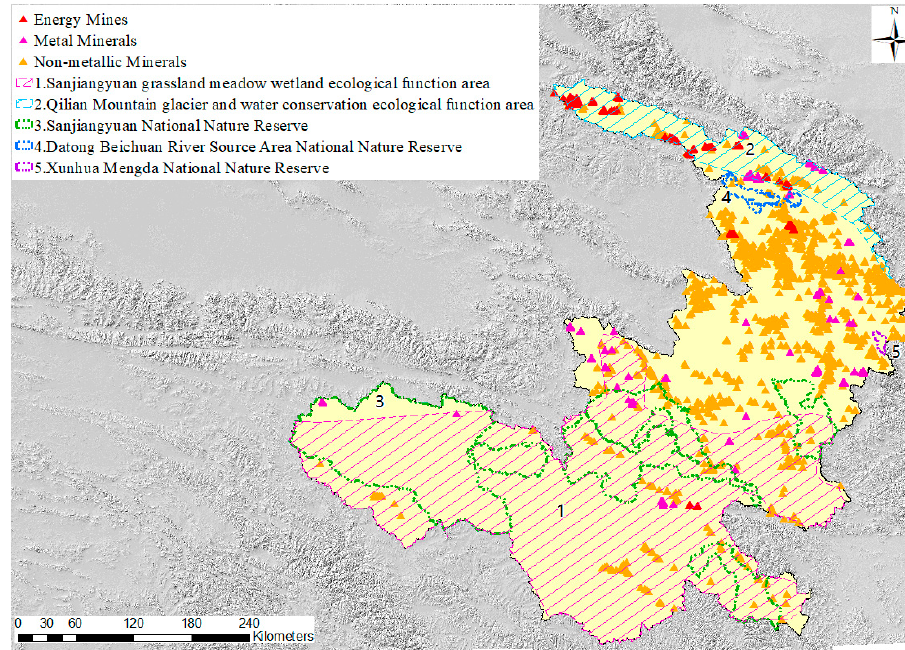
Figure 4. Distribution map of mines. Table 4. Ecosystems damaged by